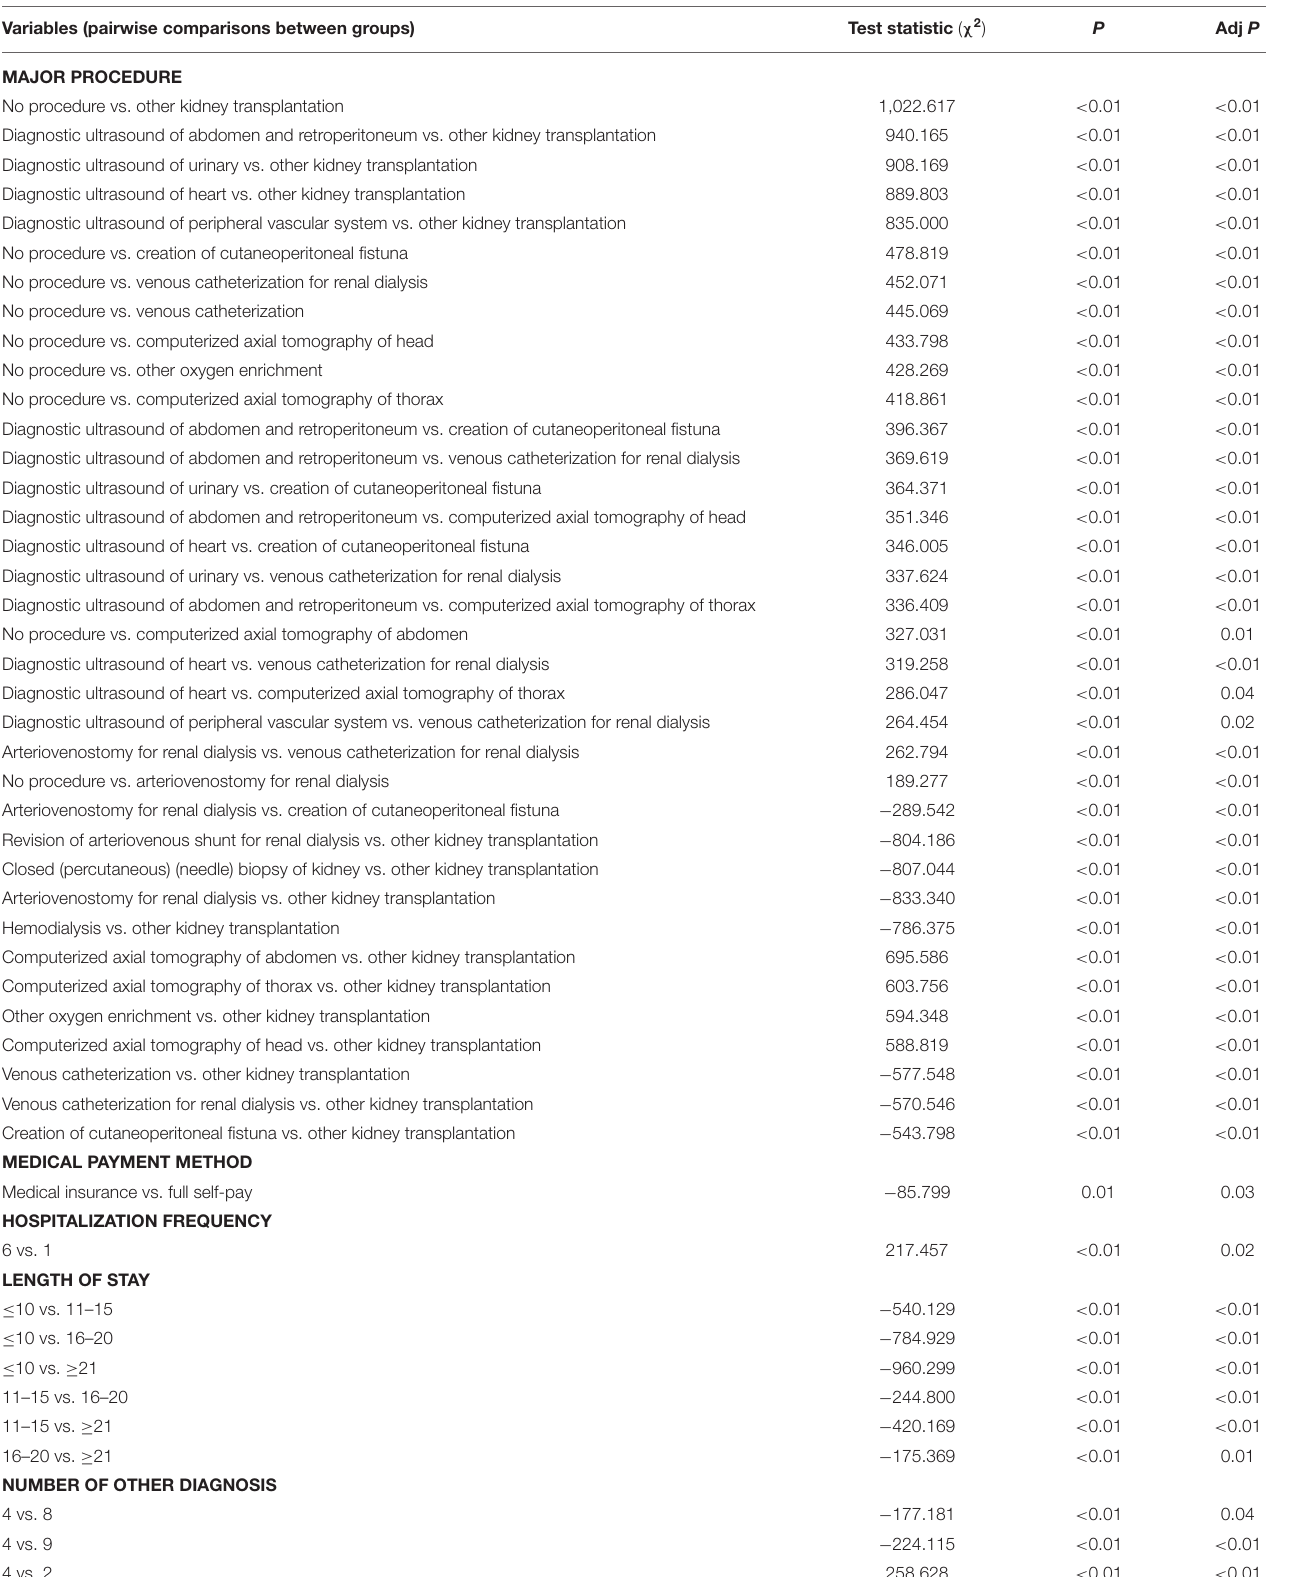
TABLE 3 | Significance results of pairwise